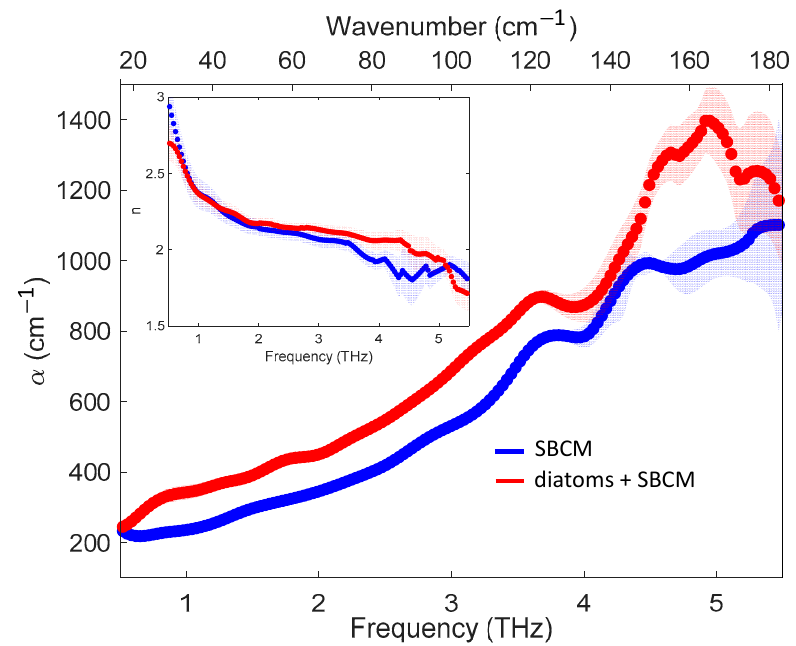
Figure 2. The THz absorption spectra of SBCM (blue curve) and diatoms in SBCM (red curve). In the inset, the corresponding refractive indexes are shown. The shaded areas indicate the measurement statistical error with a confidence level of 66% (one σ ). The shaded areas overlap with the marker size up to 3.5 THz. On the upper x -axis we report the light wavenumber in cm − 1 .